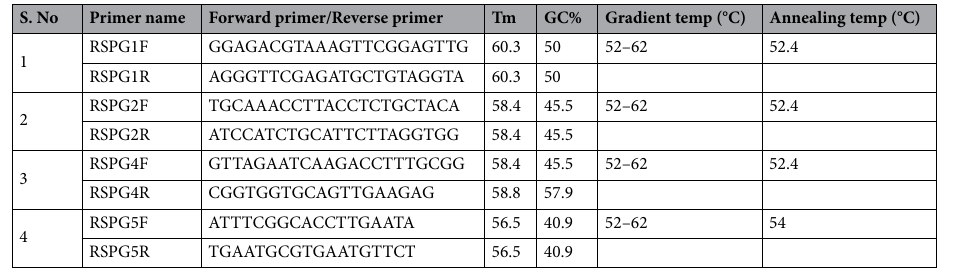
Table 2. Primers designed for conventional PCR and q-PCR.